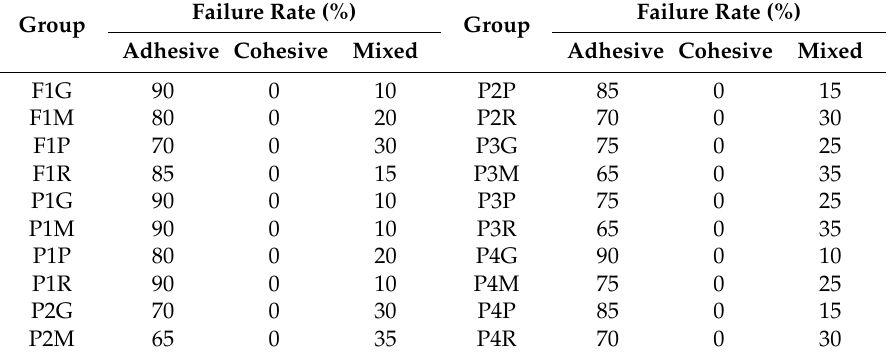
Table 4. The failure mode after the microtensile bond strengths tests. For all the groups, adhesive failure was the major failure mode and cohesive failure was not observed. The groups P2M, P3M, and P3R showed the highest mixed failure rate and the groups F1G, P1M, P1G, P1R, and P4G manifested the lowest mixed failure